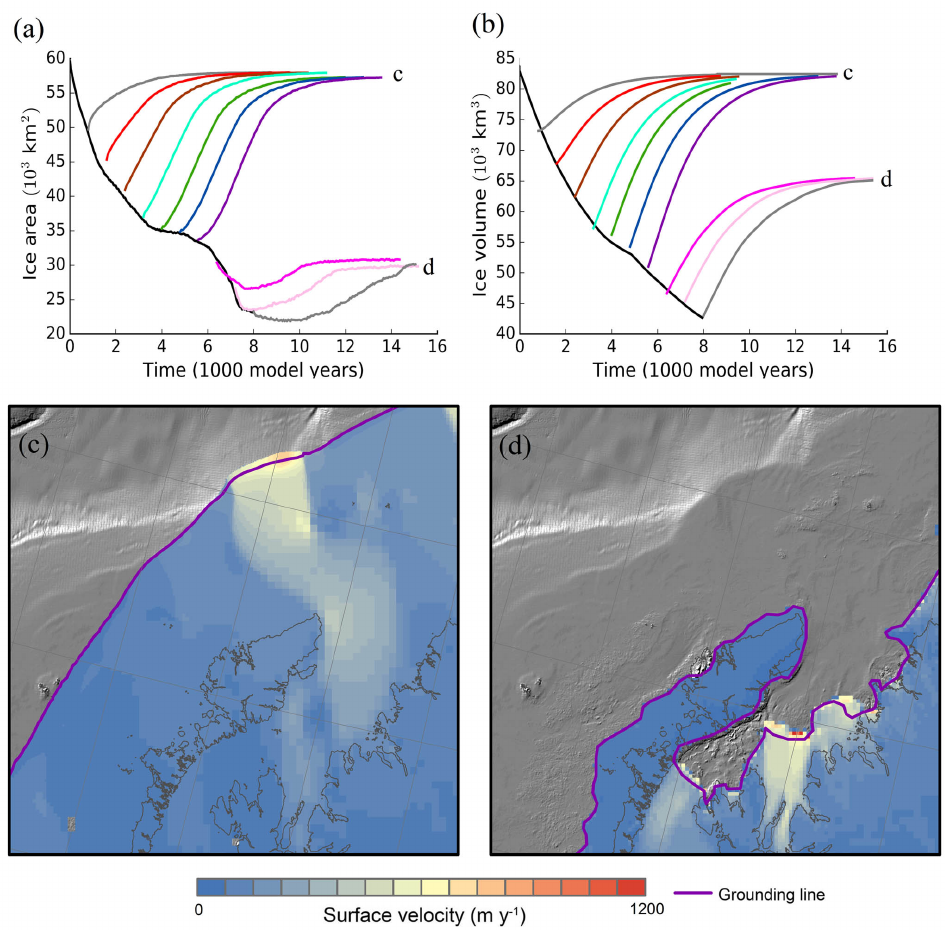
Figure 7. Results of the ensemble of READVANCE simulations testing instability in the Minch Ice Stream. The contemporary coast is shown as a thin grey line. (a, b) Evolution of the ice sheet area (a) and volume (b) over the Minch sector in the RETREAT (black) and READVANCE simulations (coloured lines). Line colours correspond to those of Fig. 6, such that the initialisation of the READVANCE simulations is 400 years later than the timing of the grounding line positions shown in Fig. 6. Labels “c” and “d” indicate the “maximum” (c) and “collapsed” (d) stable states with corresponding panels showing the respective surface ice sheet velocity (myr − 1 ) and grounding line locations (purple